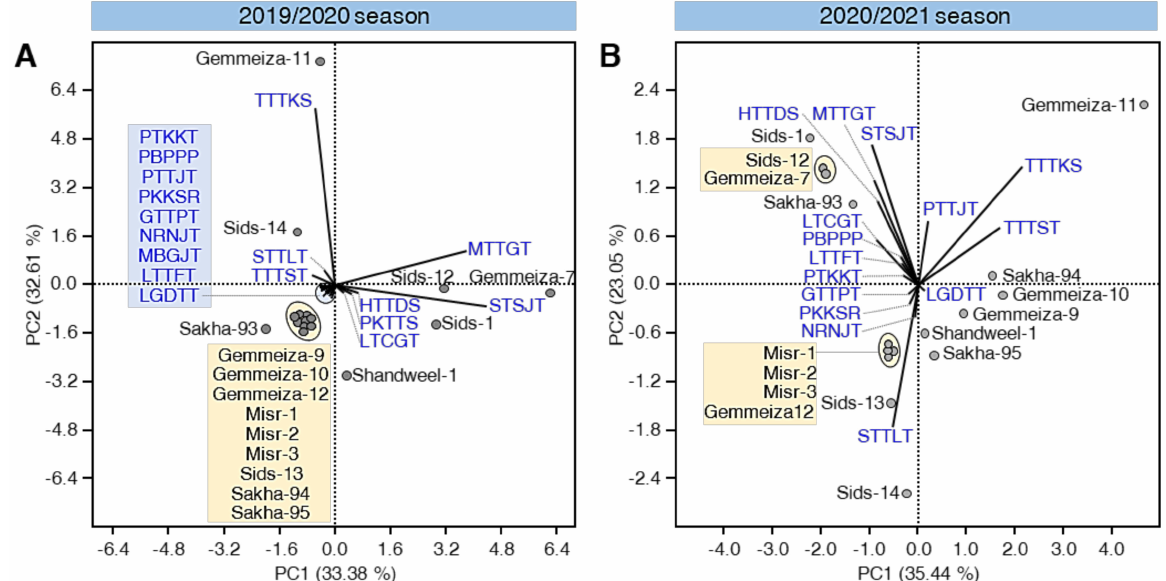
Figure 4. Principal component analysis (PCA) of individual physiological races of P. triticina detected on commercial wheat cultivars in Egypt during 2019/2020 and 2020/2021 seasons. ( A , B ) PCA-scatter plots and their associated loading plots using data collected during 2019/2020 and 2020/2021 seasons,